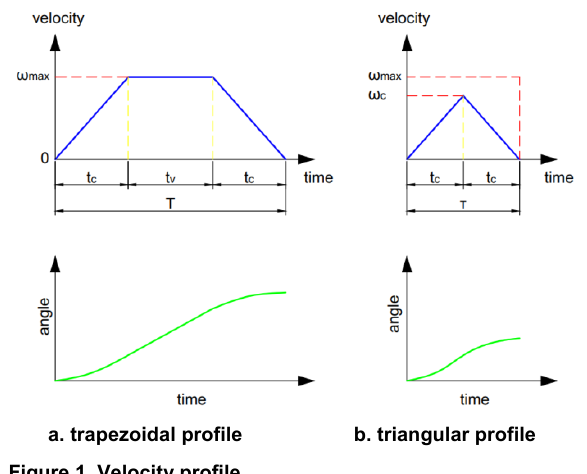
Figure 1. Velocity